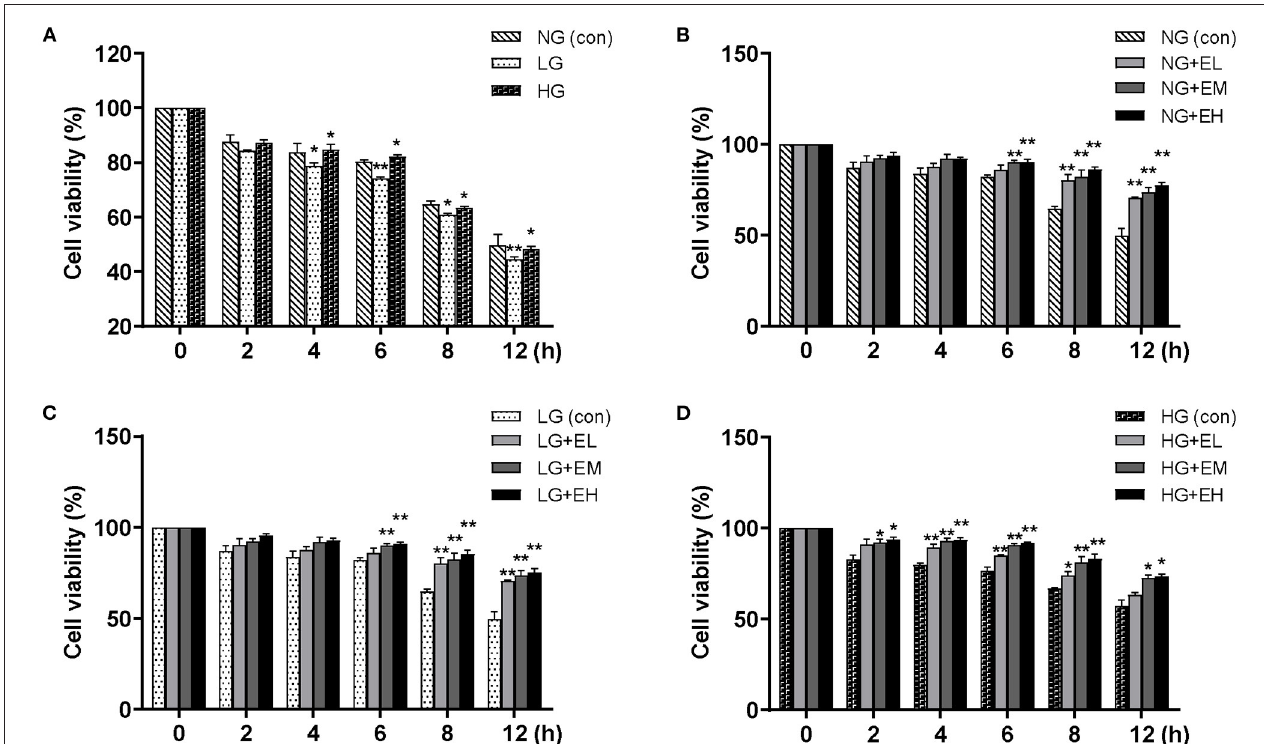
FIGURE 1 | E2 enhances PMNs viability. PMNs were treated with NG (5.5mM), LG (2.5mM), HG (25mM), NG + EL (20 pg/mL), NG + EM (200 pg/mL), NG + EH (450 pg/mL), LG + EL, LG + EM, LG + EH, HG + EL, HG + EM and HG + EH, for 0, 2, 4, 6, 8, and 12h. (A–D) PMNs viability detected by CCK-8. The results are shown as the mean ± SD ( n = 3). The t -test was used to analyze differences. * P < 0.05, ** P < 0.01. The asterisk indicates a significant difference between the treatment group and the control group